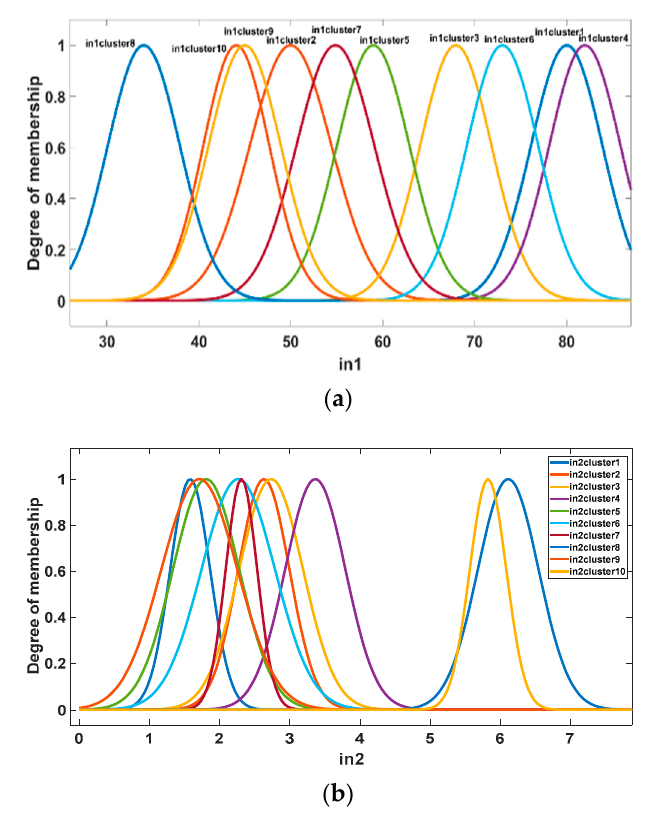
Figure 3. Input membership functions ( a ) input 1 ( b ) input 2.